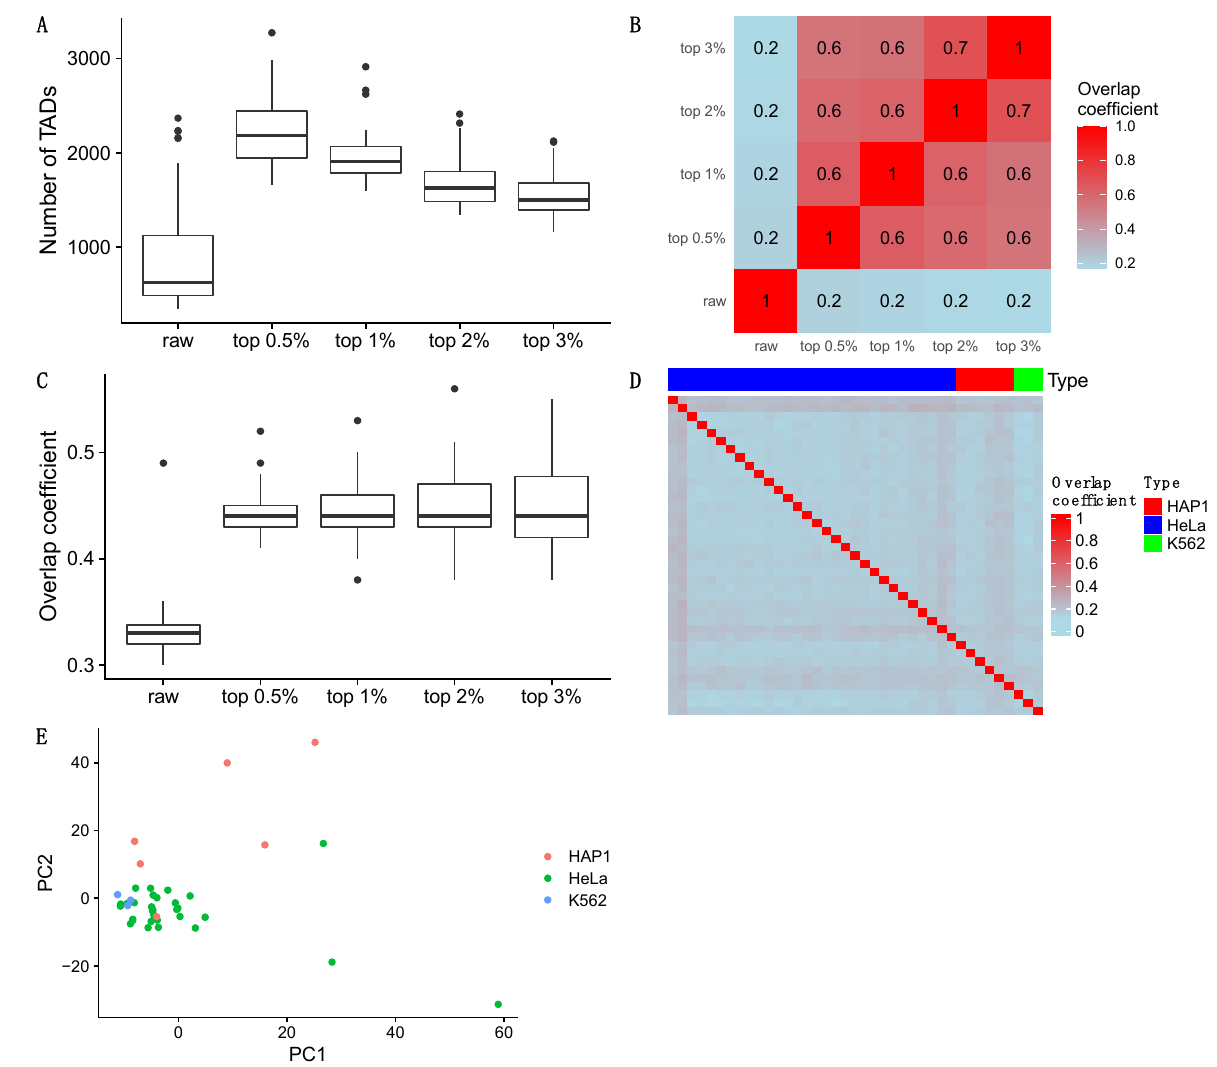
Figure 7. Results for TAD detection on 30 HeLa cells at 50 kb resolution for raw single-cell and imputed (four different top parameters) Hi-C. ( A ) The number of TADs scHiCEmbed detected on raw and imputed (four different top parameters) single-cell Hi-C. ( B ) Average overlap coefficient between each pair of the five TAD-boundary sets when allowing ± 1 bin mismatch. ( C ) Overlap coefficients between each of the five TAD boundary sets and TAD boundaries called from bulk Hi-C when allowing ± 1 bin mismatch. ( D ) Overlap coefficients between any two TAD boundary sets of 39 single cells (30 HeLa cells, six HAP1 cells, and three K562 cells) called on imputed single-cell Hi-C data with top 1% parameter when allowing ± 1 bin mismatch. ( E ) Dimensionality reduction in genome-wide TAD boundary profiles for the 39 single cells.